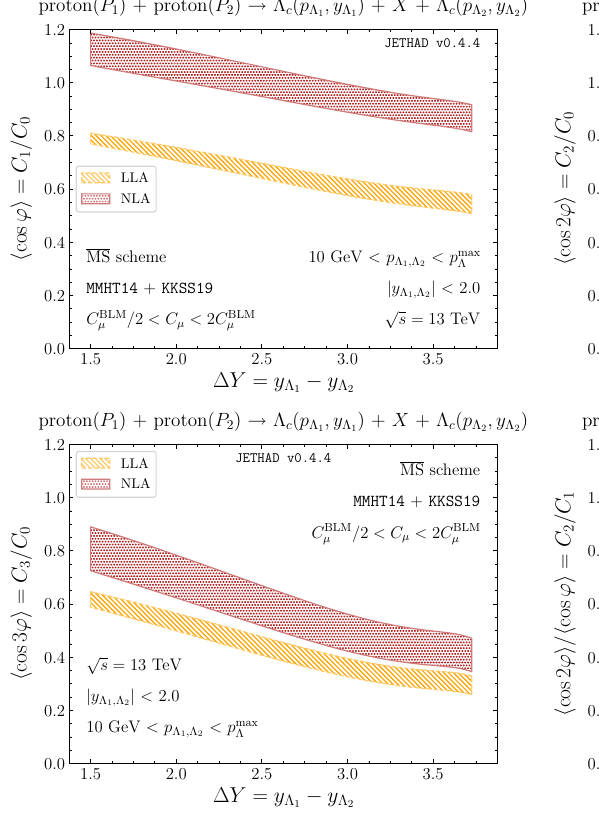
ing from scale variation and numerical integrations. Text boxes inside panels show transverse-momentum and rapidity